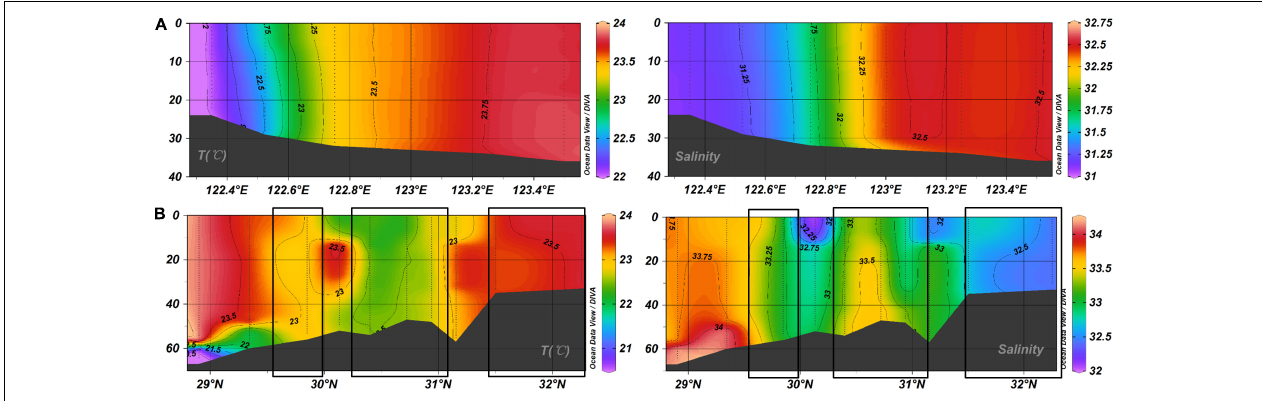
FIGURE 9 | Vertical distributions of temperature and salinity along (A) 32 ◦ N, (B) 123 ◦ E in October 2018. The boxes in (B) represent the vertical water mixing.